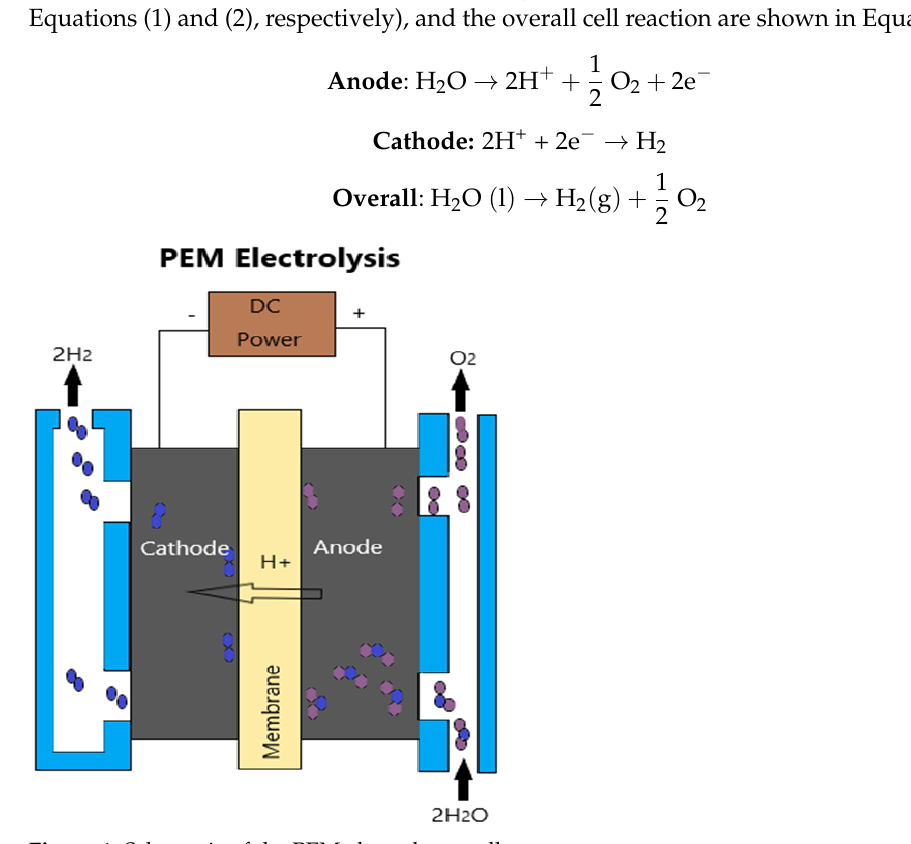
trolyzer cell requires the maximization of the hydrogen production rate of the cell. Many